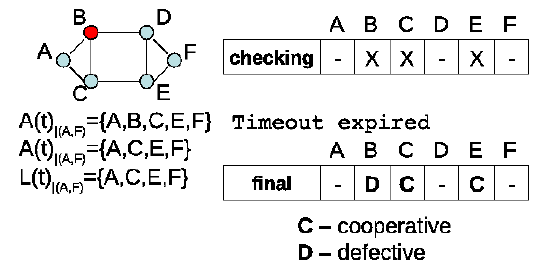
Figure 4. Algorithm